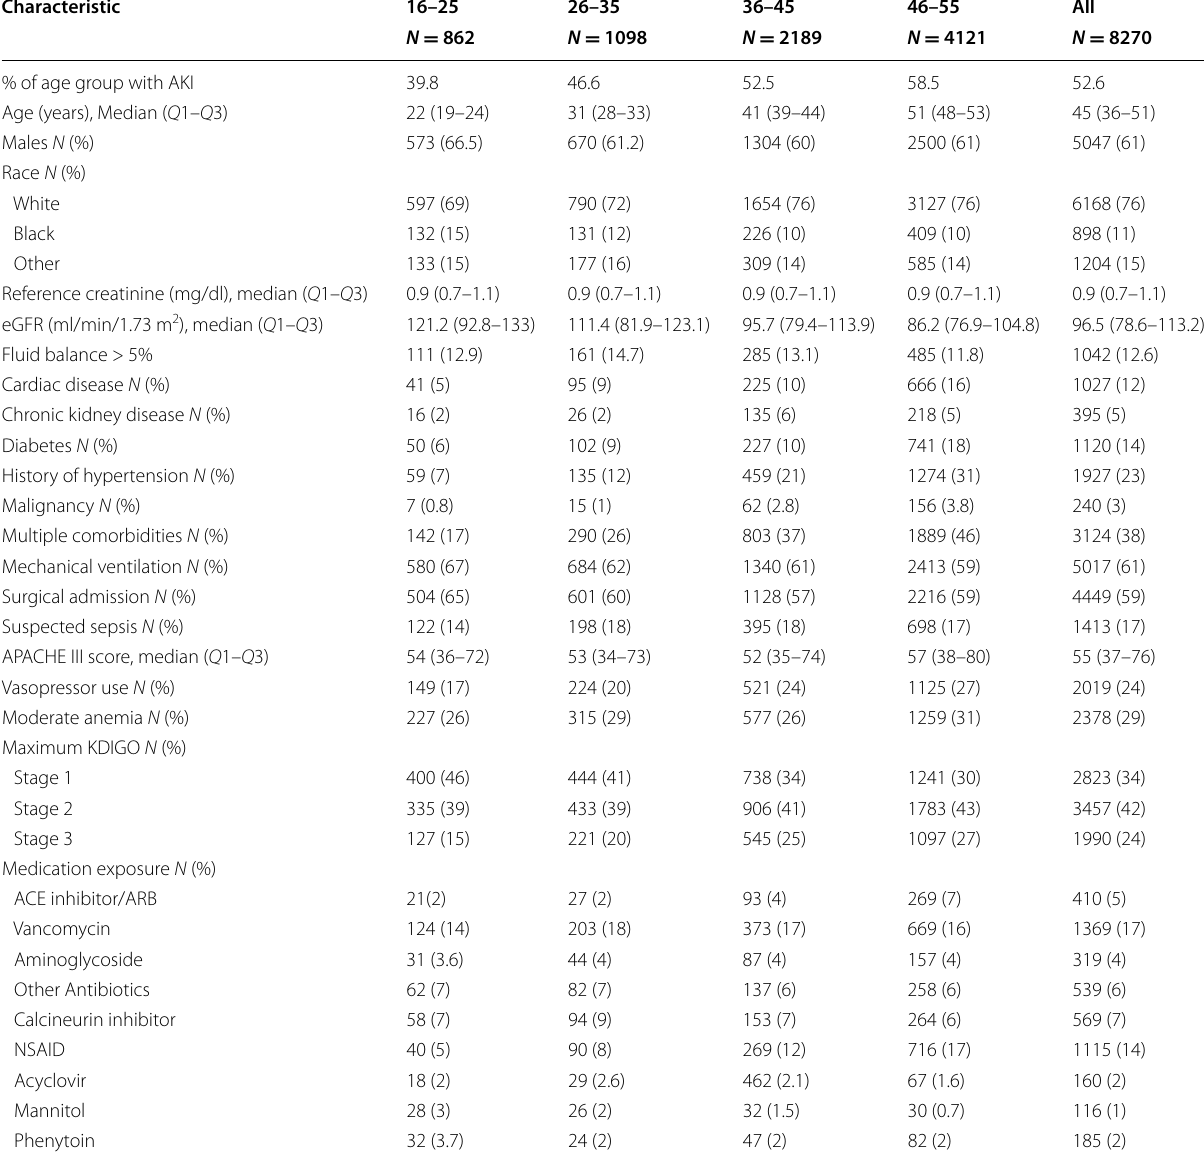
AKI acute kidney injury, eGFR estimated glomerular filtration rate, APACHE Acute Physiology and Chronic Healthy Evaluation, KDIGO Kidney Disease Improving Global Outcomes, ACE angiotensin-converting enzyme, ARB angiotensin II receptor blocker, NSAID nonsteroidal anti-inflammatory drug